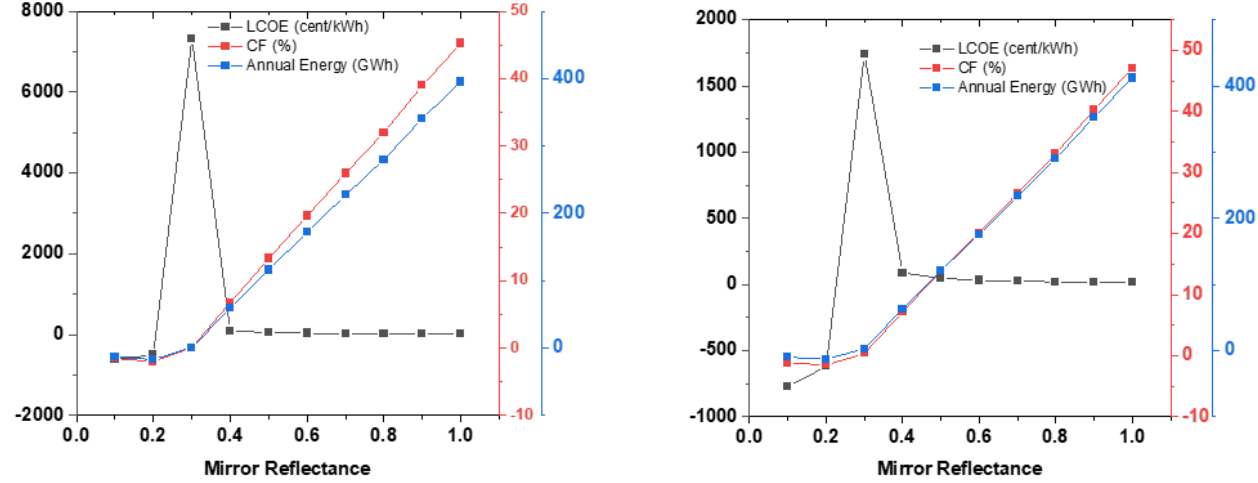
Figure 8. Effect of mirror reflectance on some metrics for Rankine power cycle with HTF A ( left ) and HTF B ( right ).